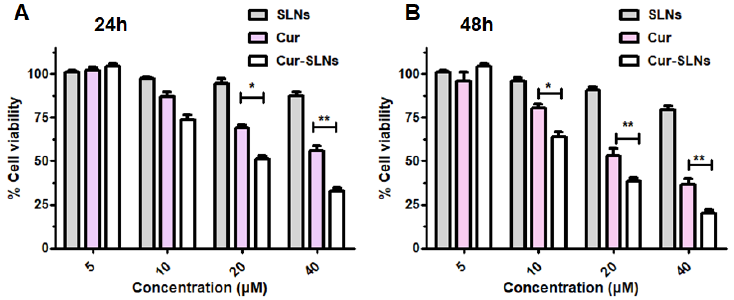
Figure 2. In vitro cell viability analysis of SLNs, Cur, and Cur-SLNs in SKBR3 breast cancer cells. The cells were treated with the respective formulations, and incubated for ( A ) 24 h and ( B ) 48 h. Data are represented as percentage of viable cells. * p < 0.05; ** p < 0.01.